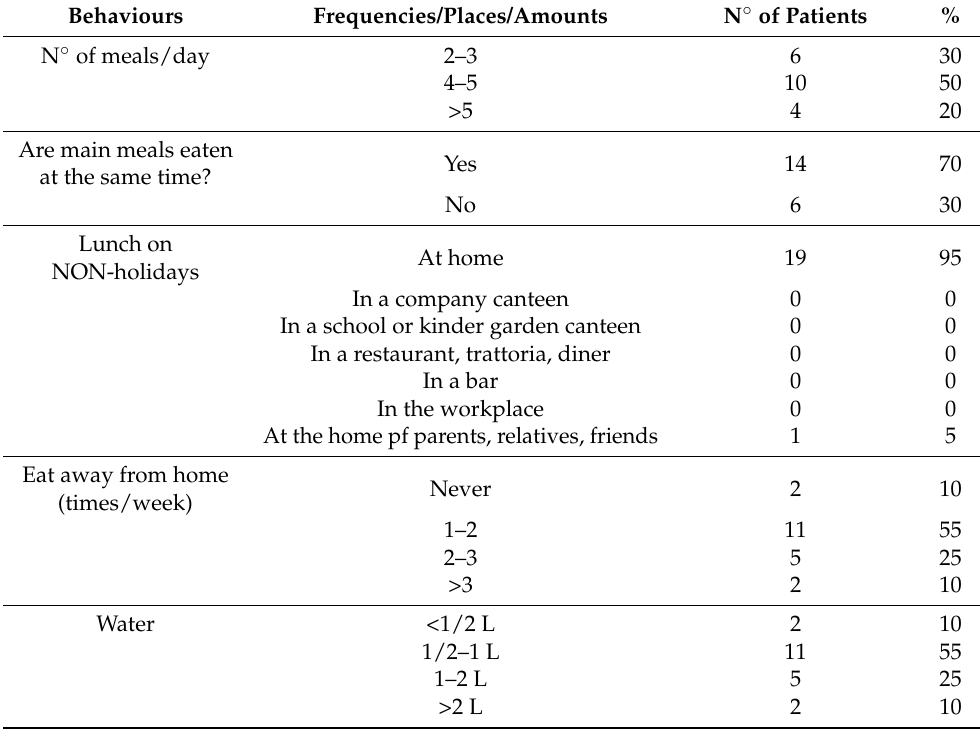
Table 3. Dietary behaviours at baseline of SNAS patients during COVID-19 pandemic.